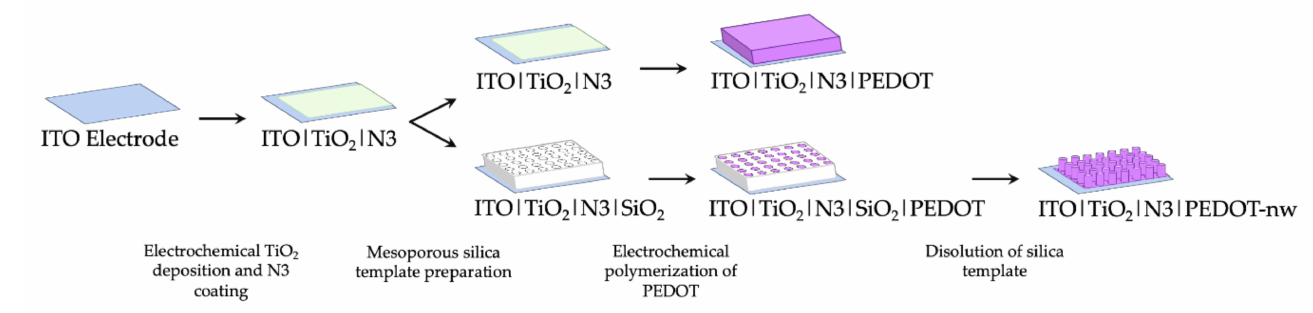
Figure 1. Schematic representation of preparative